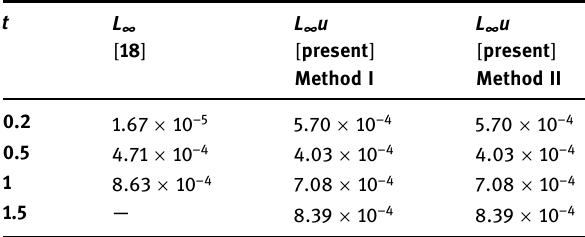
Table 11: Comparison of maximum absolute error at di ff erent time